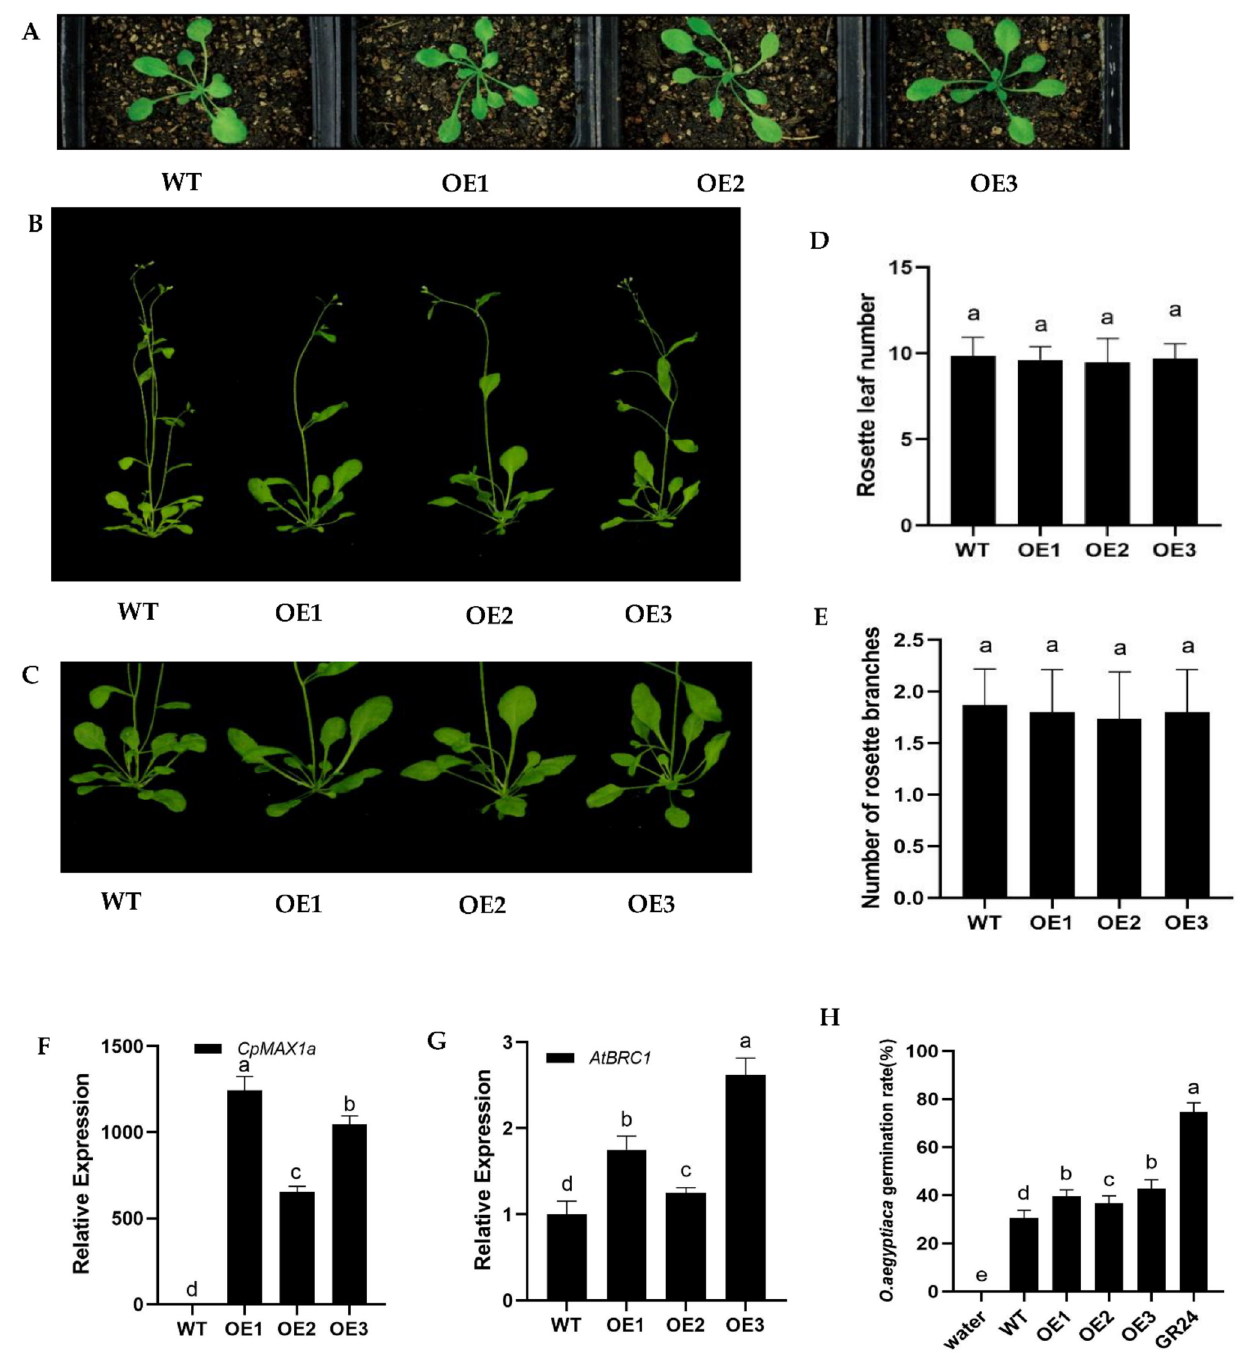
Figure 5. Branching phenotypes of the CpMAX1a -OE lines. ( A ) Seedlings grown in soil for 2 weeks. ( B , C ) Rosette branching phenotype of CpMAX1a -OE plants at 35 days after transplanting. ( D ) Num- ber of rosette leaves in the WT and CpMAX1a -OE lines. ( E ) Number of rosette branches in the WT and CpMAX1a -OE lines. ( F ) Expression levels of CpMAX1a in the transgenic and WT plants. ( G ) Expres- sion levels of AtBRC1 in the CpMAX1a -OE lines and WT. ( H ) The extraction solution of CpMAX1a -OE lines induced Orobanche seeds germination experiment; water as a negative control, and GR24 as a positive control. Data shown are the mean of three biological repeats ± standard deviation (SD). Different lowercase letters (a–e) above the bars indicate significant differences ( p <